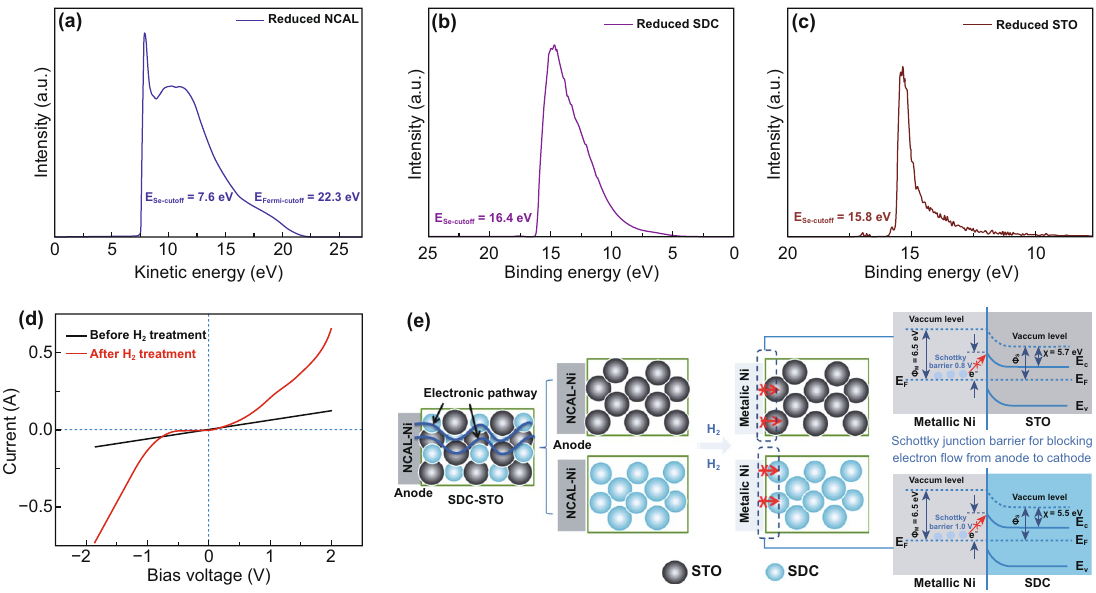
Fig. 6 UPS plots of a NCAL, b SDC, and c STO pellets treated in H 2 at 550 °C. d Current response as a function of bias voltage for the NCAL- Ni/4SDC–6STO half-cell tested at 550 °C before and after providing H 2. e Schematic diagram of the SDC–STO fuel cell reveals the electronic blocking mechanism by Schottky junction effect at anodic NiCo/electrolyte